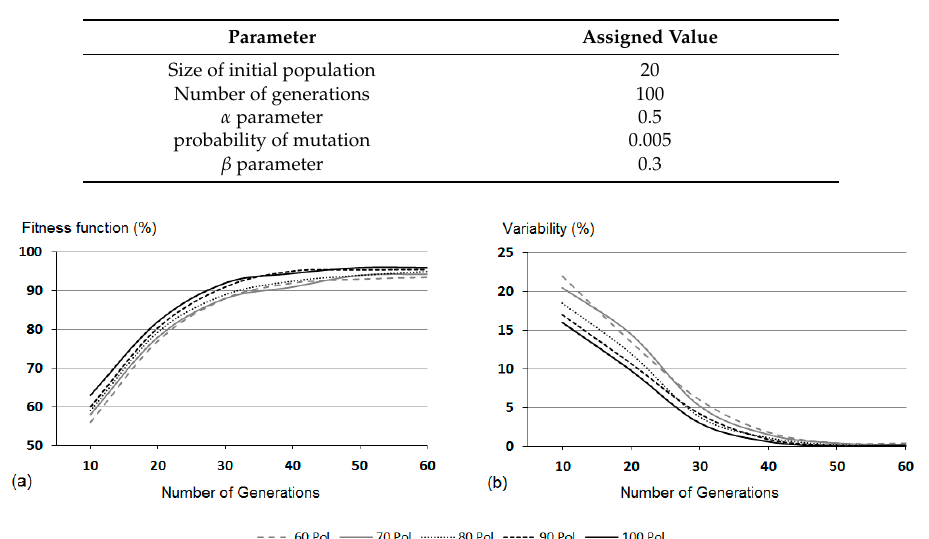
Table 1. Parameter values assigned to the RCGA.